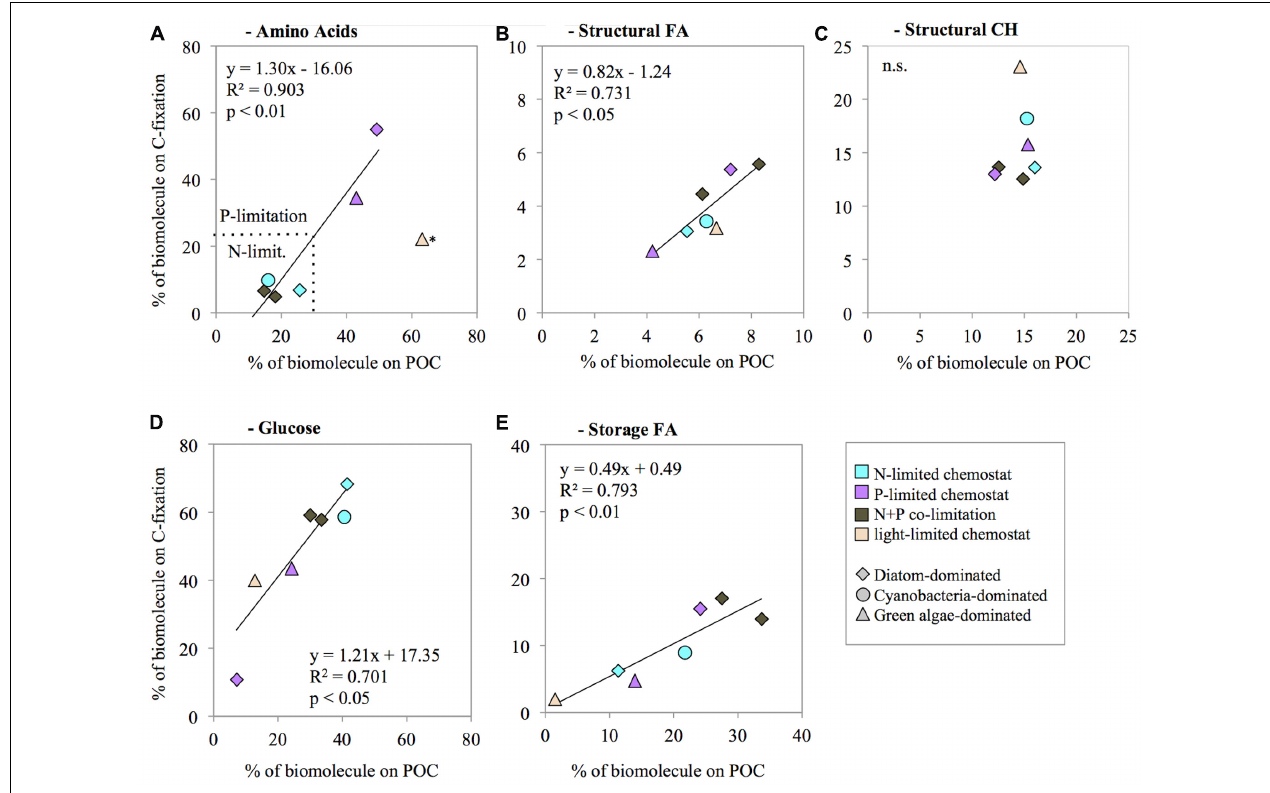
FIGURE 3 | Correlation between the contribution of biomolecules to biomass (% of POC concentration) and their contribution to biosynthesis (% of C-fixation), for amino acids (A) , structural fatty acids (B) , structural carbohydrates (C) , glucose (D) , and storage fatty acids (E) . The prevailing nutrient limitation is indicated by symbol color, the dominant phytoplankton group is indicated by symbol shape. ∗ the light-limited chemostat was treated as an outlier in panel A